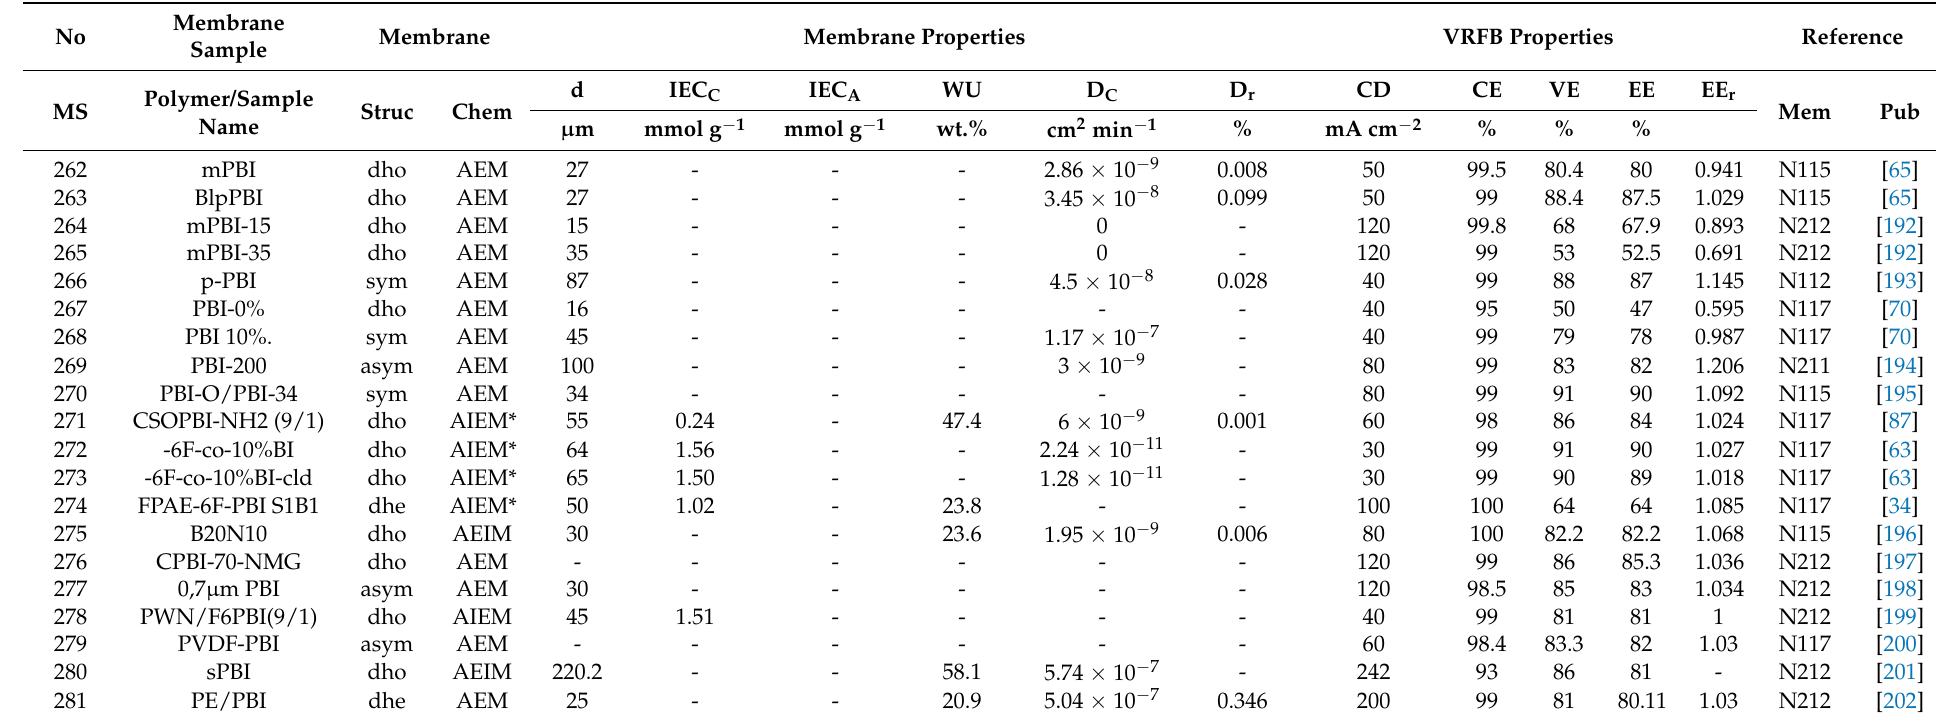
Table 12. List of PBI-based N -heterocycle membrane